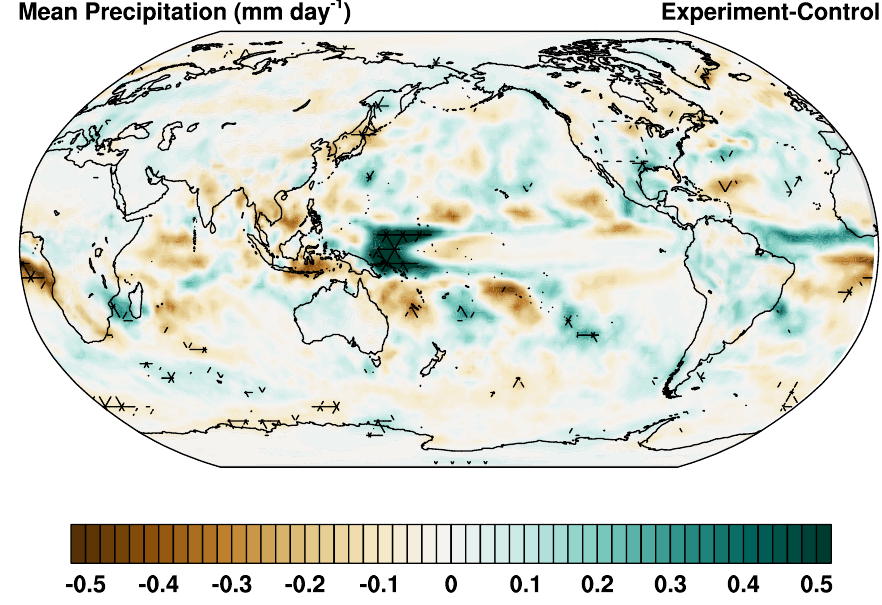
Figure 4. The same as Figure1 but for change in total precipitation